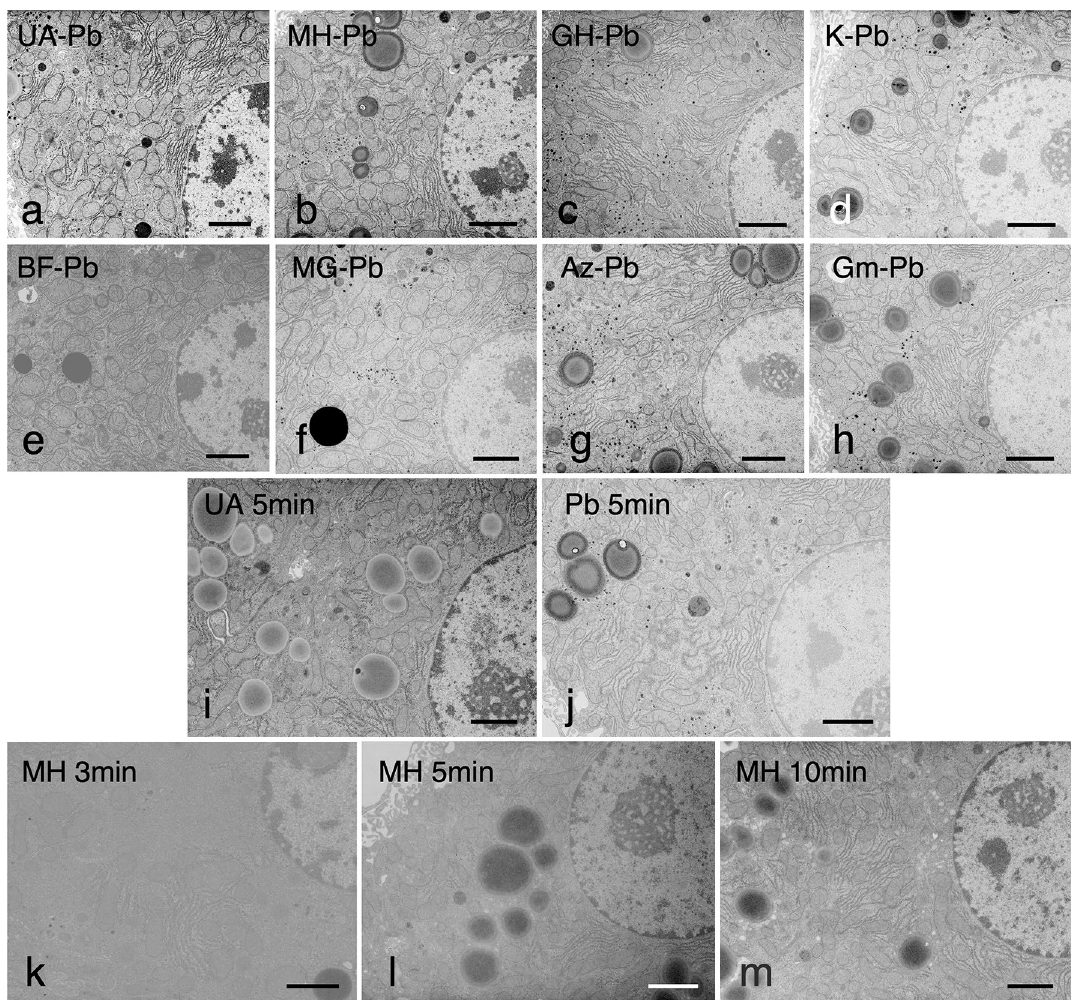
Figure 1. ( a – h ) EM images of mouse liver stained with various dyes followed by RPb. Ultrathin sections of mouse liver fixed using the conventional 2% glutaraldehyde and 1% osmium tetroxide fixation and embedded in epoxy resin, doubly stained with ( a ) UA and RPb (UA–Pb), ( b ) MH and RPb (MH–Pb), ( c ) Gill No.3 hematoxylin and RPb (GH–Pb), ( d ) Kernechtrot and RPb (K–Pb), ( e ) basic fuchsin and RPb (BF–Pb), ( f ) methyl green and RPb (MG–Pb), ( g ) alizarin and RPb (Az–Pb), and ( h ) Giemsa solution and RPb (Gm–Pb). Hepatocytes, including the nucleus and cytoplasmic organelles, were stained clearly to different degrees of contrast with all dyes upon post-staining with RPb. The contrast of almost all organelles was highly enhanced upon double staining with MH and RPb, to the same extent as that with UA and RPb. Bar = 2 μm. ( i — m ) Ultrathin sections of mouse livers solely stained with ( i ) UA for 5 min, ( j ) RPb for 5 min, ( k ) MH for 3 min, ( l ) MH for 5 min, and ( m ) MH for 10 min. Cells were not clearly displayed in the 3 or 5 min MH single staining, but slight contrast enhancements were observed in the U, RPb and 10 min MH stainings. Bar = 2 μm. The results represent at least three independent experiments with similar citric acid are only present in MH, suggesting that these are responsible for the better electron staining effect. Further investigation will be needed in the future. Ultrathin sections of mouse livers were stained solely with UA for 5 min, RPb for 5 min, MH for 3 min, MH for 5 min, or MH for 10 min. Cells were not clearly observed in the 3 min or 5 min MH single staining samples, but slight contrast enhancements of the hepatocytes were observed in the UA, RPb, and 10 min MH stained samples (Fig. 1i–m). Lilly Mayer’s and Carracci hematoxylins showed numerous section breakages, presumably because these stains contain glycerin (Table 1). With the Gill No. 3 stain, there was no structure-specific increase in contrast, and the entire section was stained darkly. Digital images were subjected to gray value (i.e. contrast) line analysis using ImageJ image processing software to semi-quantitatively determine the image quality. Figure 2 shows the line profile displaying two-dimensional graphs of the intensities of pixels along black lines within the images. There was a significant difference in contrast between the upper panel (MH-RPb and UA-RPb, Fig. 2a,b) and lower panel (Gill No.3-RPb and Kernechtrot-RPb, Fig. 2c,d). The MH-RPb and UA-RPb had lower gray values (i.e. electron density) compared with Gill No.3-RPb and Kernechtrot-RPb, indicating that MH-RPb and UA-RPb enhanced the contrast relative to the cell membrane